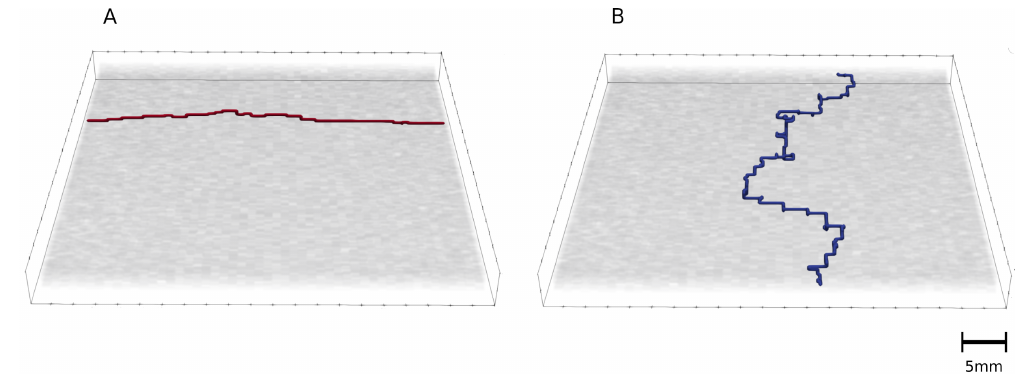
Figure 2. Traces of the shortest possible path of excitation propagation in the longitudinal ( A ) and transversal ( B ) directions in the model of 60% fibrosis with 4-node length